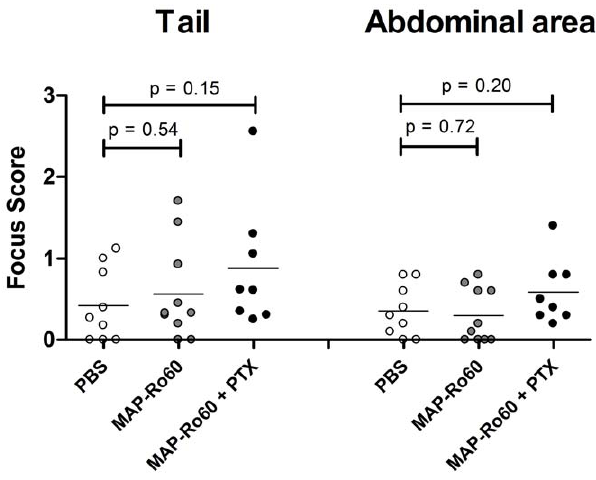
Figure 3. Unchanged salivary gland lymphocytic infiltrates in SJL/J mice. SGs from all animals used for saliva collection, were analyzed at the end of the study for lymphocytic infiltrates. The score of each mouse is shown individually. The location of injection is indicated. Data shown are mean values. P-values are indicated and were determined by unpaired Student’s t-test.